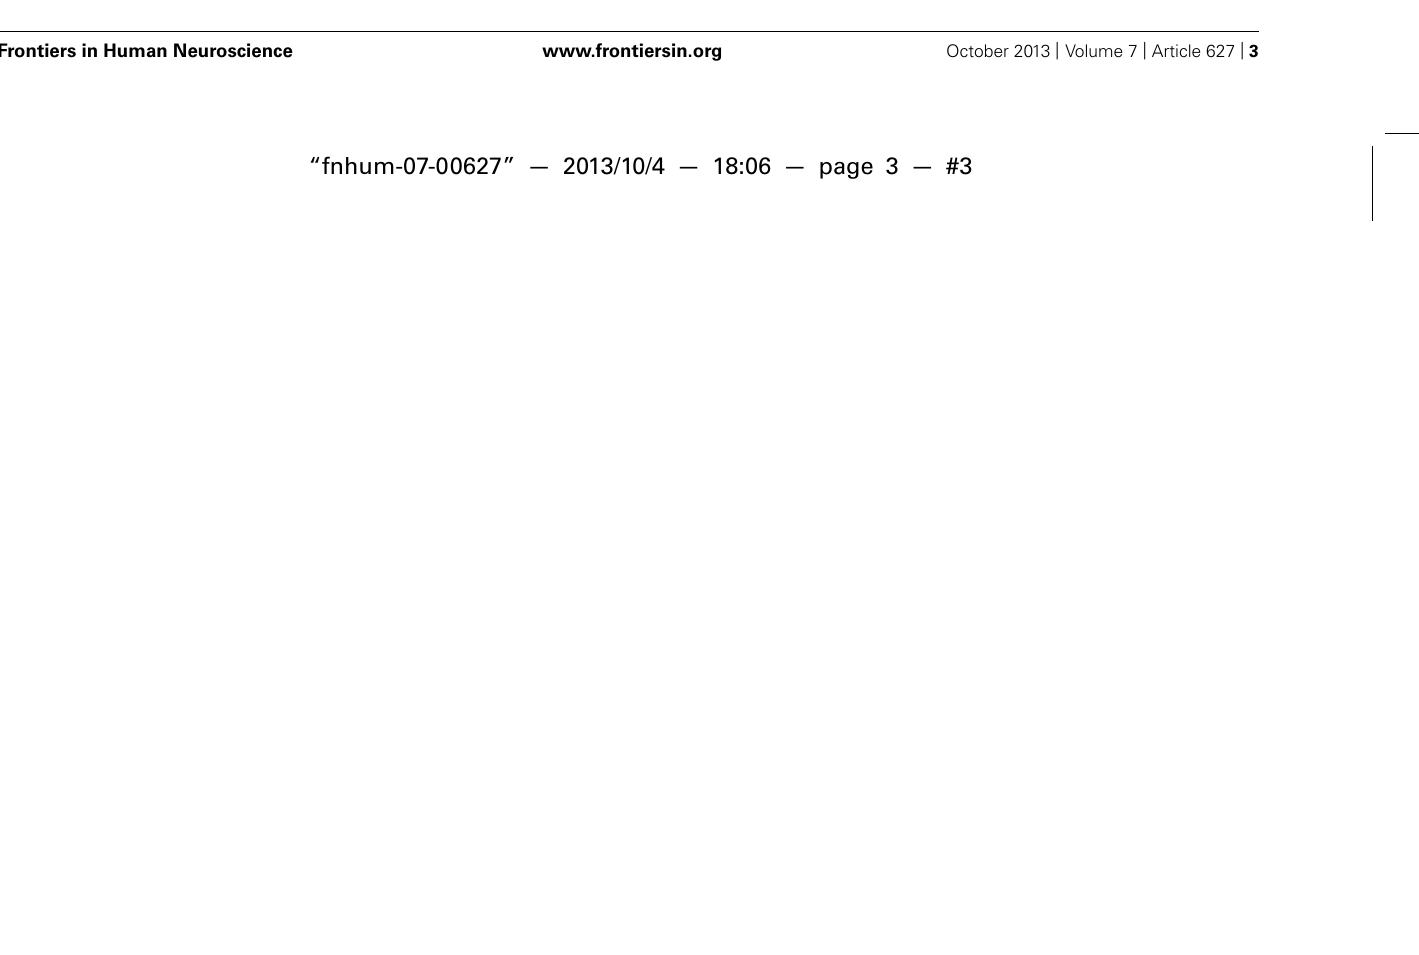
trial n − 1 ) or T1-switch trial (when T1-load on trial n , was